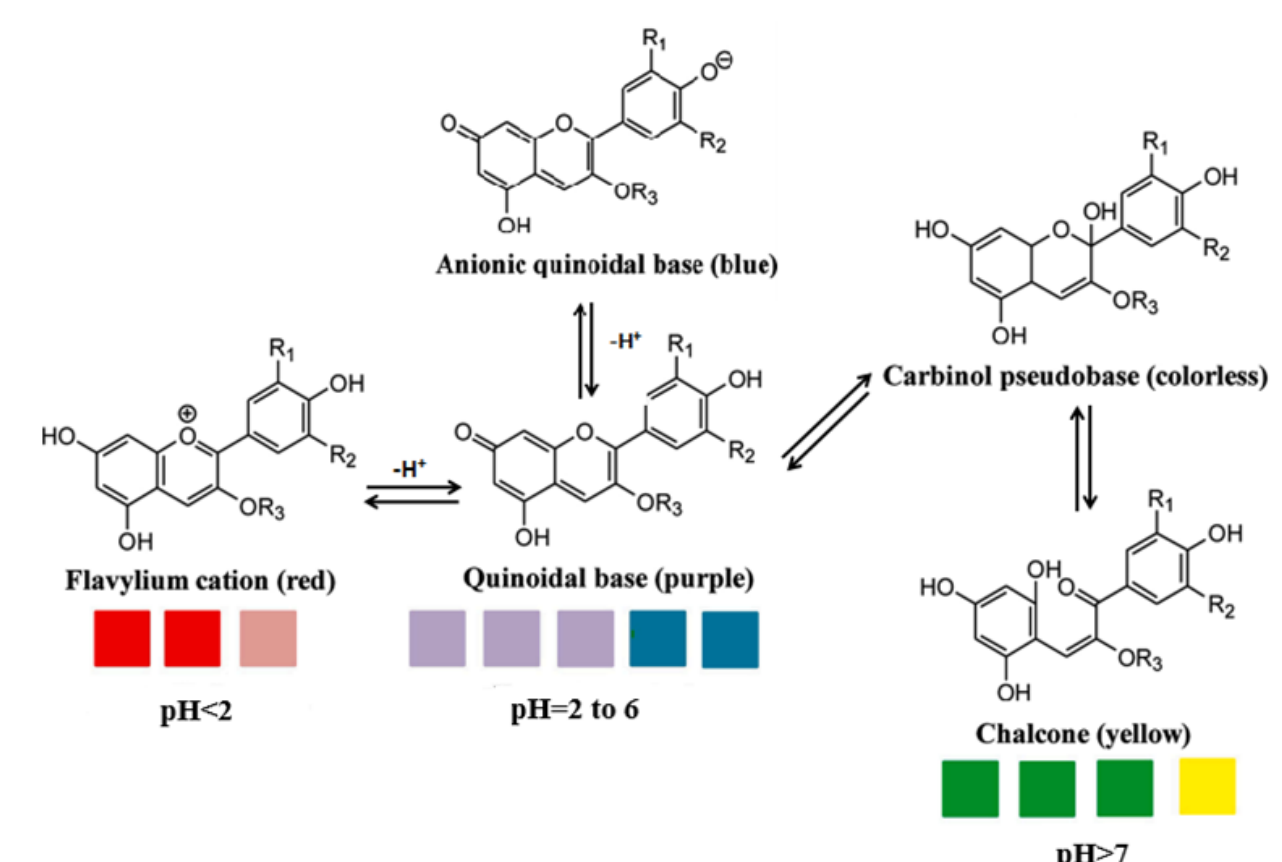
Figure 1. Color changes of red cabbage anthocyanin-rich extract at different pH values.